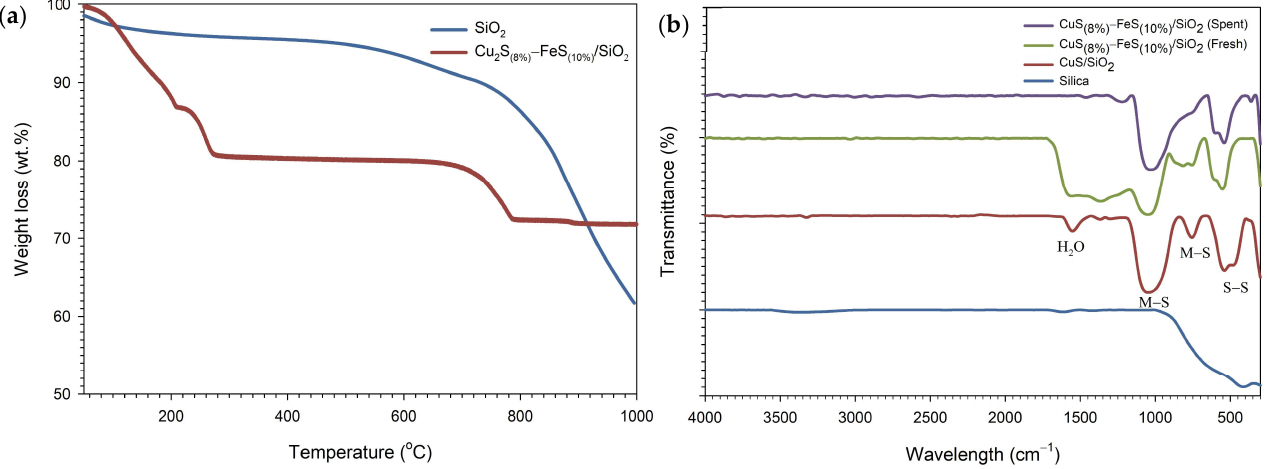
Figure 4. ( a ) Thermogravimetric analysis (TGA) of the prepared samples under nitrogen atmosphere with a heating rate of 10 degrees·min −1 and ( b ) FTIR results of the prepared SiO 2 and catalyst.